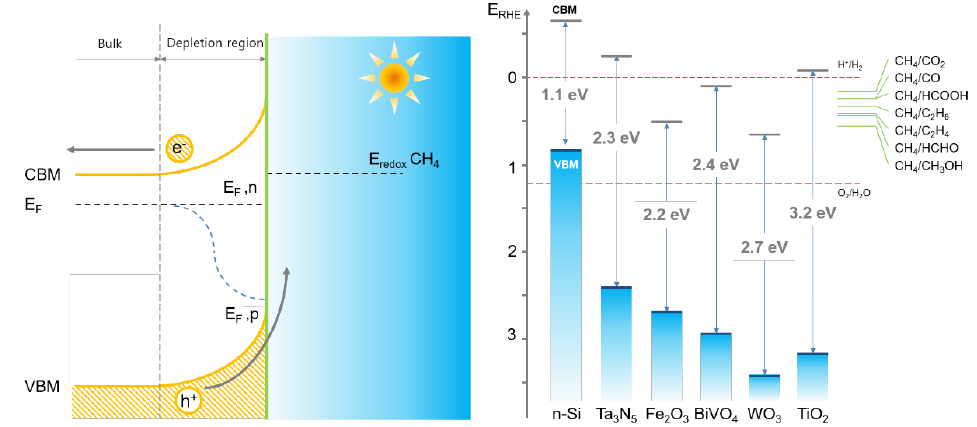
Figure 3. Schematic energy diagram of methane oxidation with a photocatalyst ( A ) and photoelec- trochemical system ( B ).